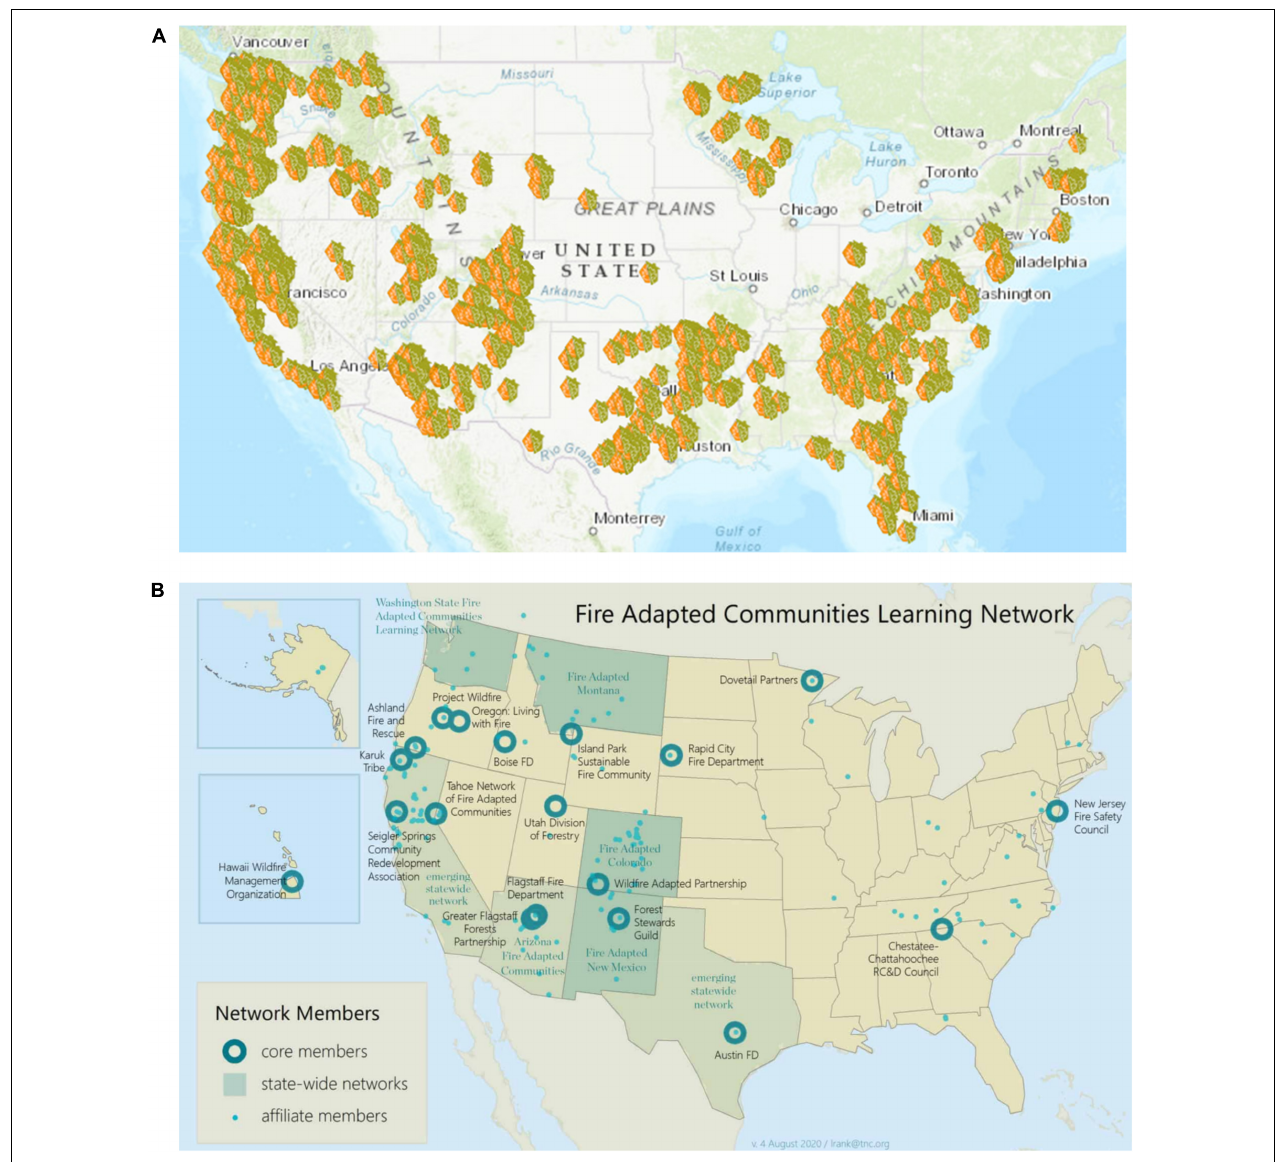
FIGURE 6 | Community education and training networks in the United States. Firewise communities (A) as of May 2021 across the United States (www.nfpa.org/firewise). Fire Adapted Communities Learning Network (B) across the United States (www.fireadaptednetwork.org).